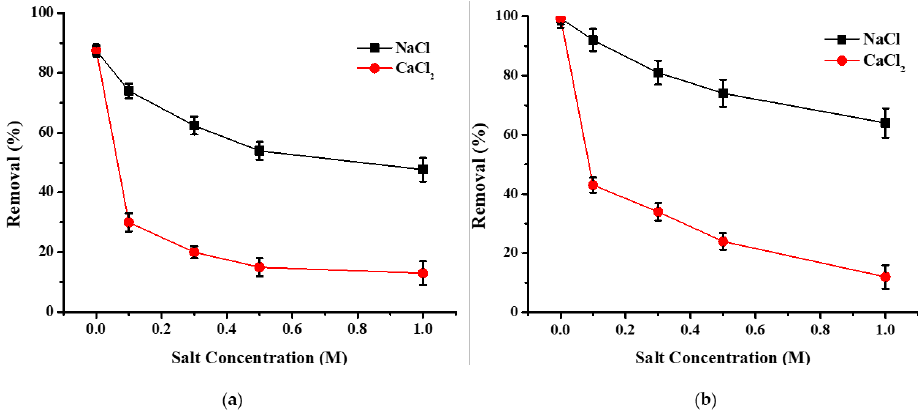
Figure 2. Effect of the ionic strength of solution on copper adsorption onto ( a ) washed hemp shives (SHI-W) and ( b ) Na 2 CO 3 activated hemp shives (SHI-C). Experimental conditions: adsorbent dose = 2 g; solution volume = 100 mL, [Cu 2+ ] = 25 mg/L, [NaCl] = [CaCl 2 ] = 0.1–1.0 M, contact time = 120 min, stirring speed = 250 rpm, pH = 5.2 ± 0.1, temperature = 22 ± 1 °C, n = 3.